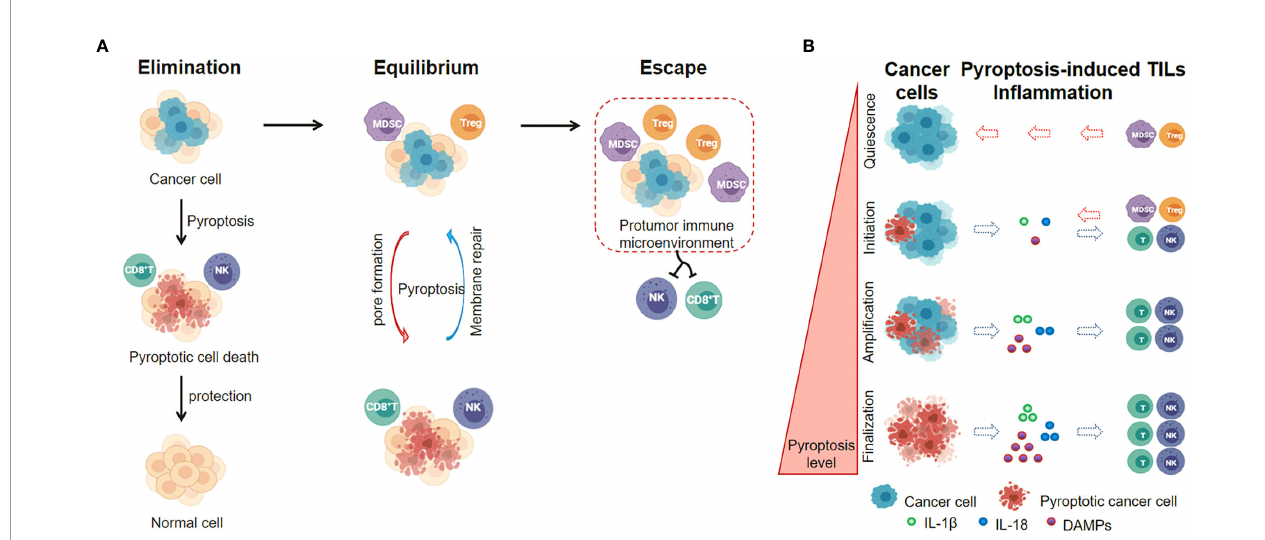
FIGURE 4 | Pyroptotic In fl ammasome signaling regulates in fl ammation and TILs within tumor microenvironment. (A) The level of pyroptotic in fl ammasomes is associated with the balance between cancer cell elimination and immune escape. (B) Pyroptosis levels in cancer cells affect the in fl ammation and TILs within tumor